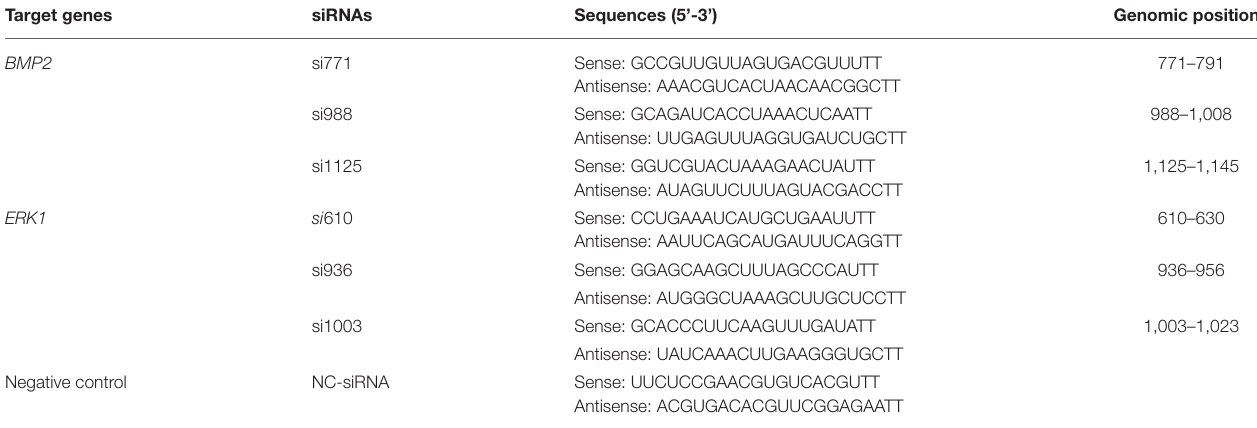
TABLE 1 | Sequences of the synthesized siRNA molecules and their positions in genomic regions of target genes (experiment 1). Target genes